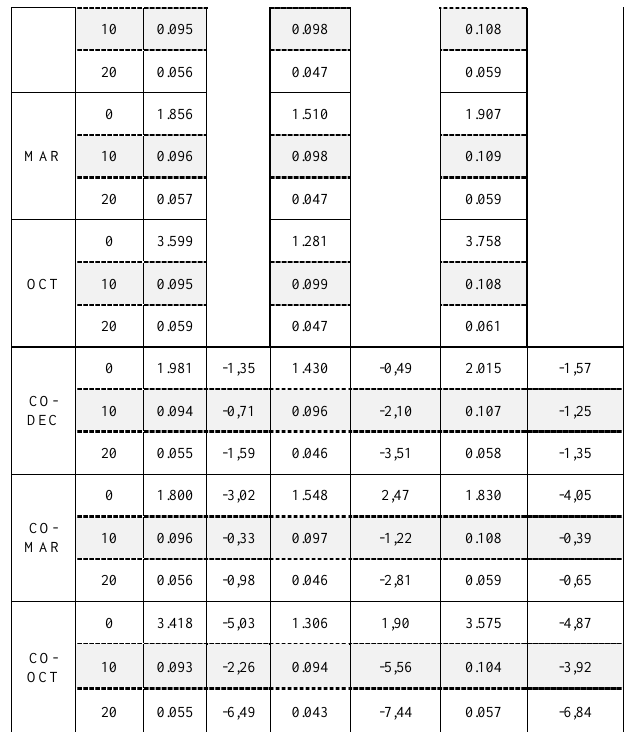
Table 3. Summary of statistics (mean error (ME), root-mean- square planar error (RMSE P ) and three-dimensional error (RMSE 3D )) measured on the 10 CPs distributed in the investigated scene. For each variable, the comparison between the models obtained from conventional and co-aligned procedures is presented in terms of percentage